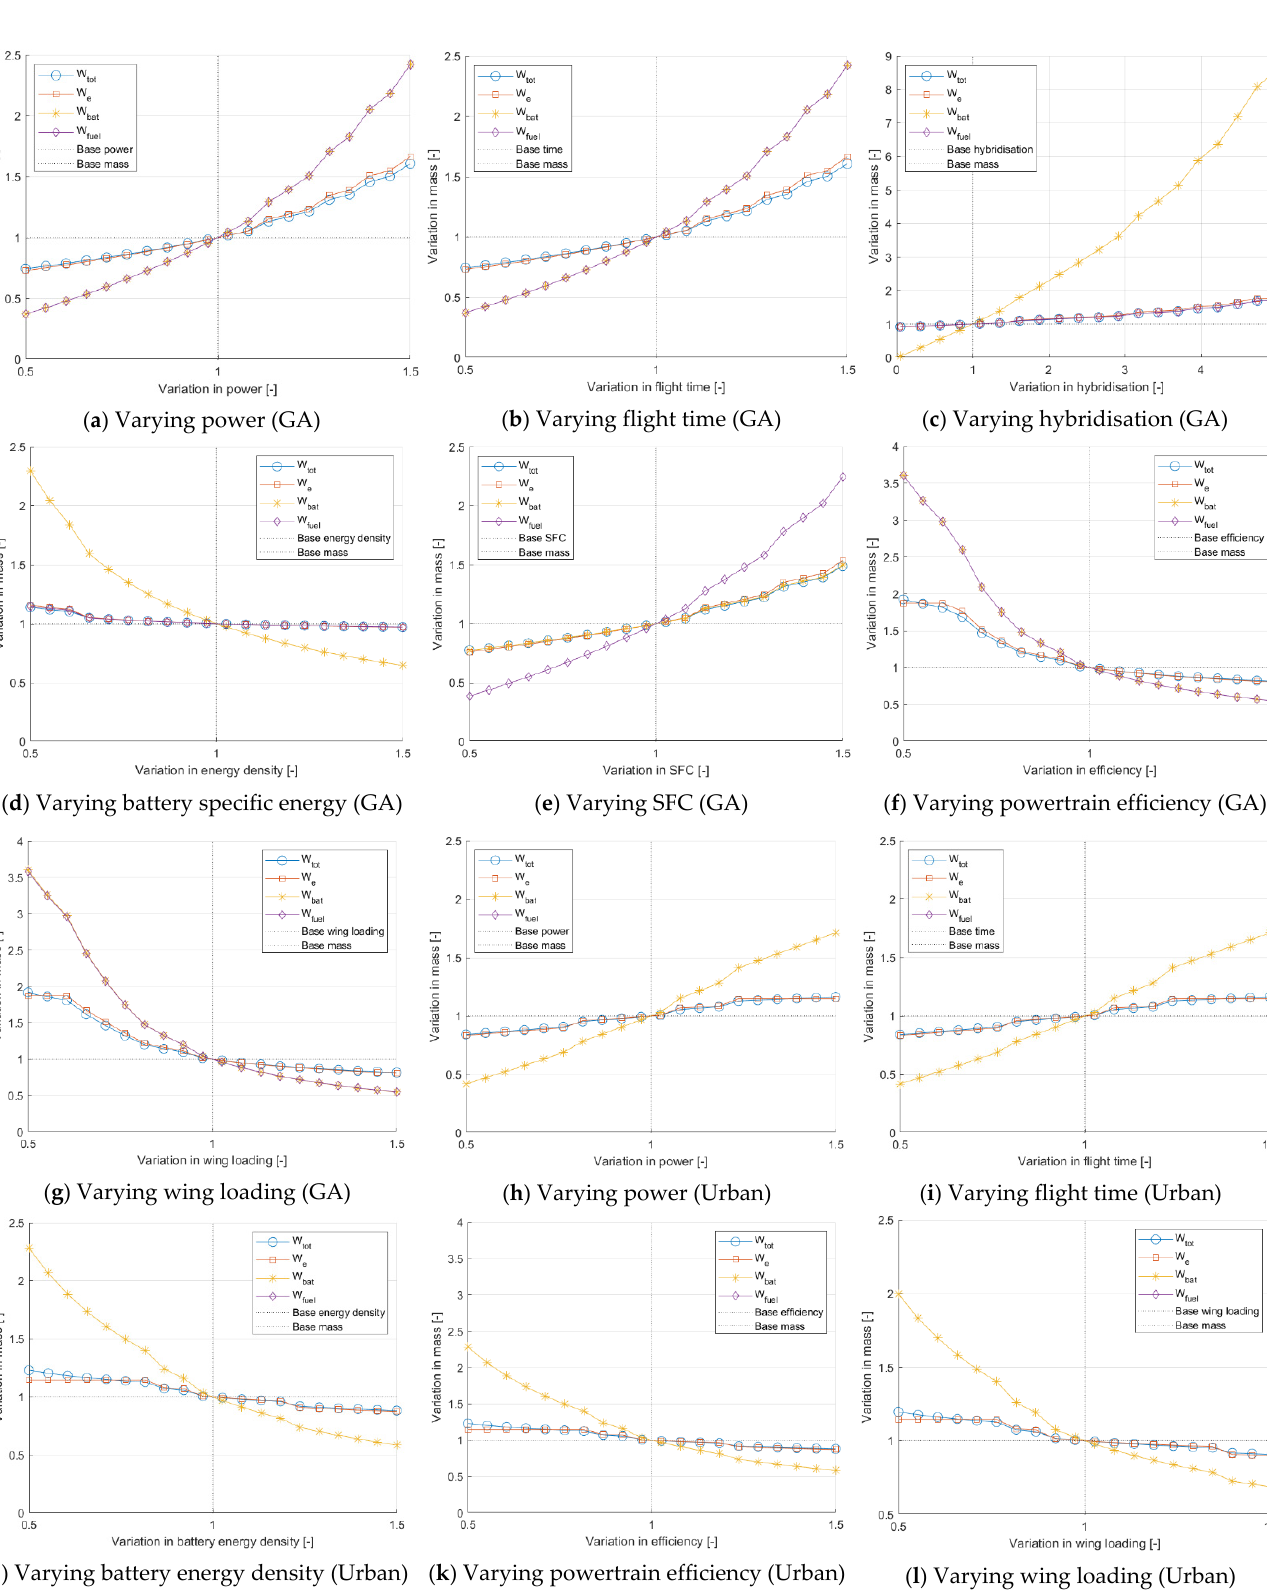
Figure 15. Variance analysis of all-electric powertrain.